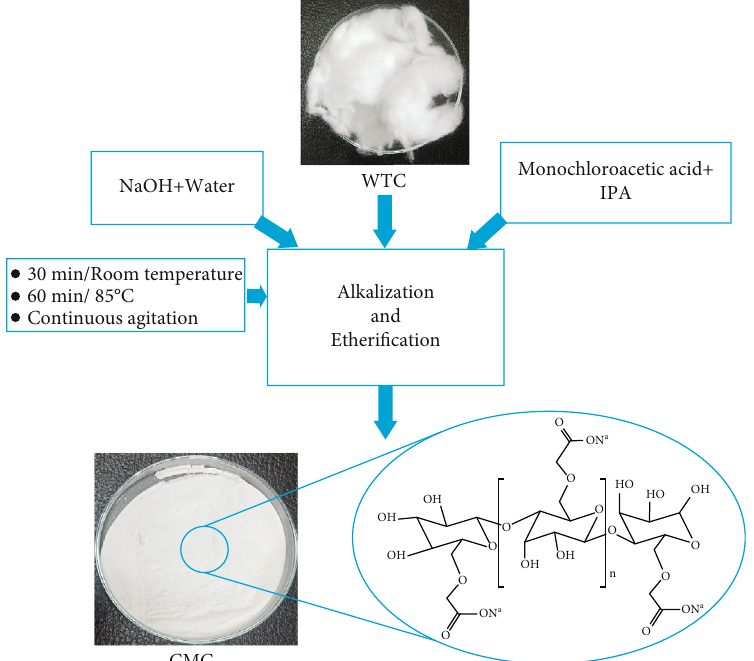
Scheme 1: Synthesis of CMC from